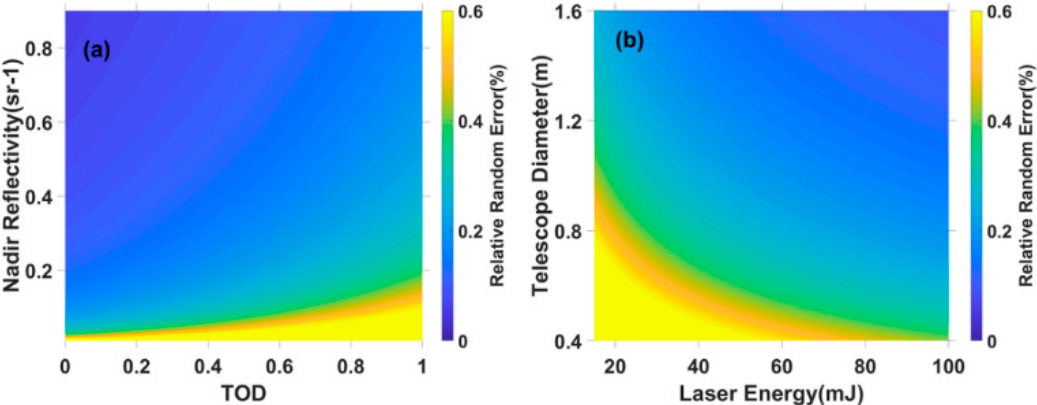
Figure 4. Changes of the relative random errors (RREs) for variations in TOD and nadir surface reflectivity ( a ) and the pulse laser energy and telescope diameter ( b ).